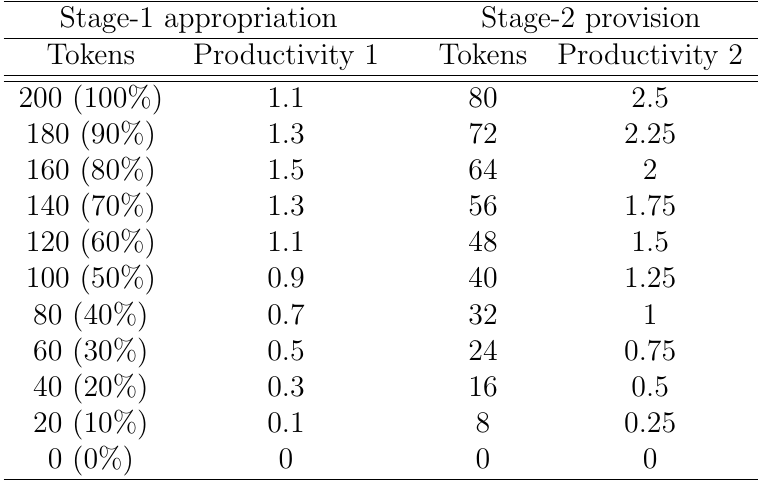
Table 1: The effects on appropriation and provision levels on stock